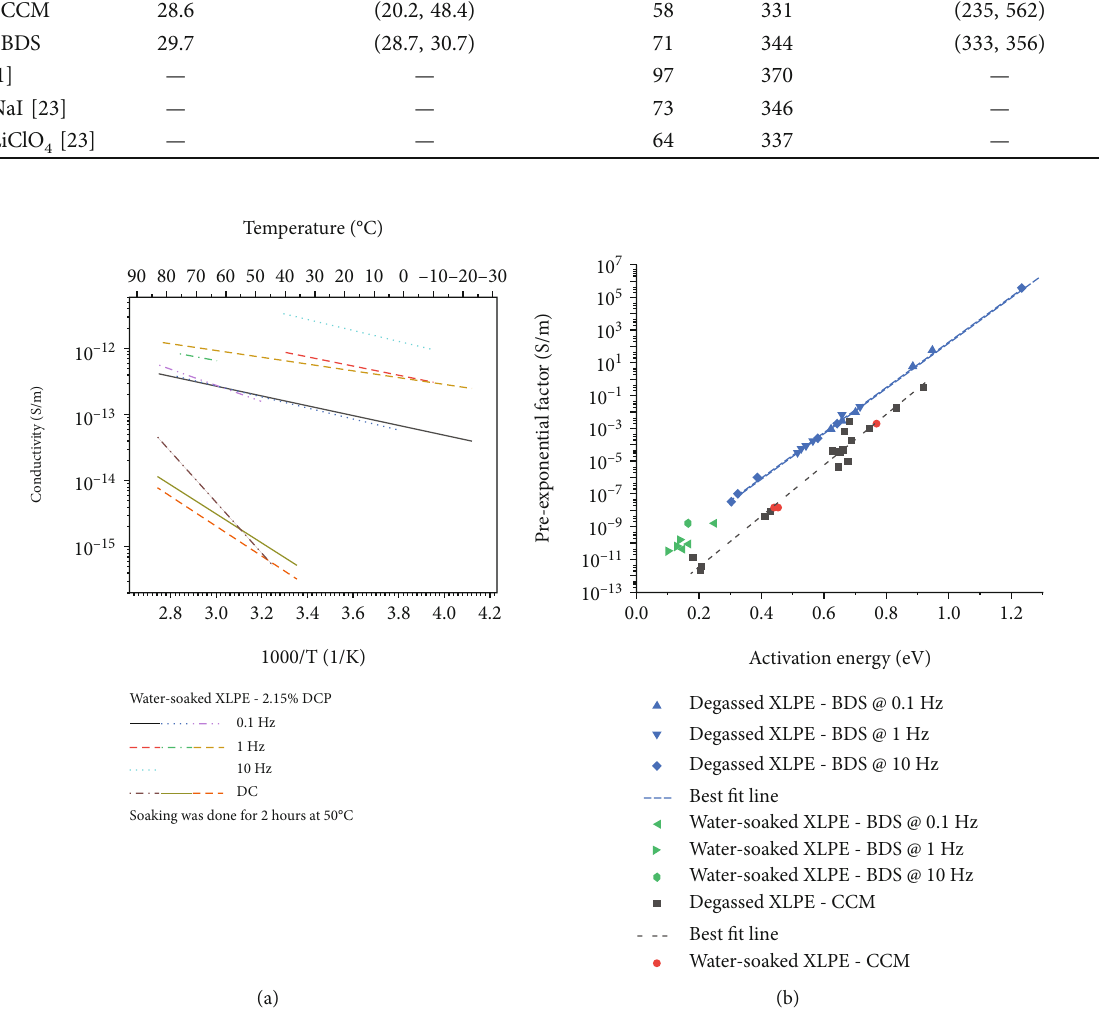
Figure 6: (a) AC conductivity vs. temperature plot and (b) compensation law plot for water-soaked XLPE samples. A comparison to the degassed XLPE samples discussed previously is included in the plot on the